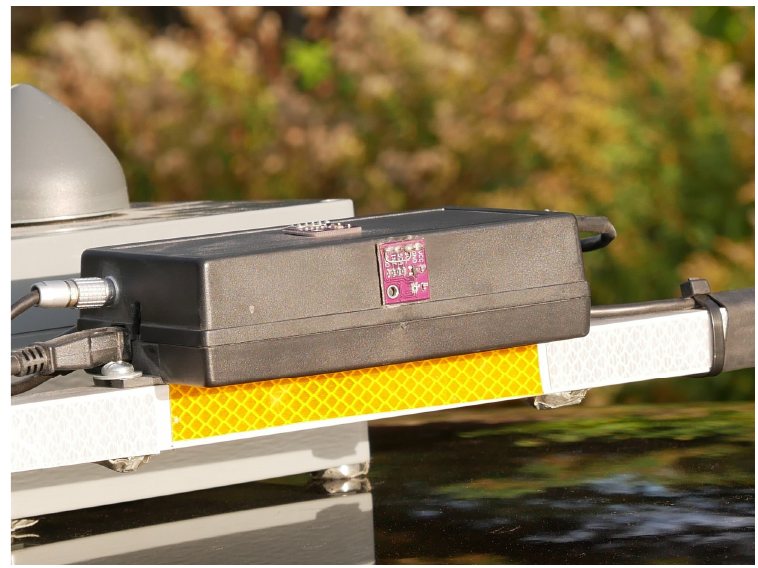
Figure 7. Illuminance sensors for horizontal and vertical plane measurement located in the central position of the measurement system.